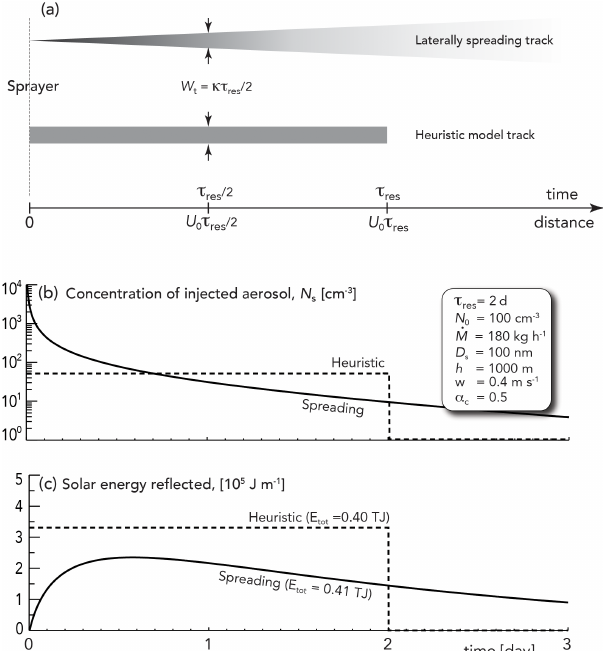
Figure 2. (a) Plan view of a realistic laterally spreading plume/track (top), and the track assumed in the heuristic model, as a func- tion of time/distance downstream of the sprayer. The shading qual- itatively indicates the injected particle concentration. (b) Injected aerosol concentration as a function of time for the two plume types, given the spray injection information in the box. A residence time τ res = 2d and a widening rate K = 1 . 85kmh − 1 are assumed, and the model is run out to 10d to capture the total reflected solar radia- tion for the spreading plume. (c) Additional reflected solar radiation per meter length of track from aerosol–cloud interactions for the two plume types. The total additional reflected energy E tot from the two plumes is very similar. In this case, approximately 43% of the energy reflected from the spreading plume occurs for times t > τ res